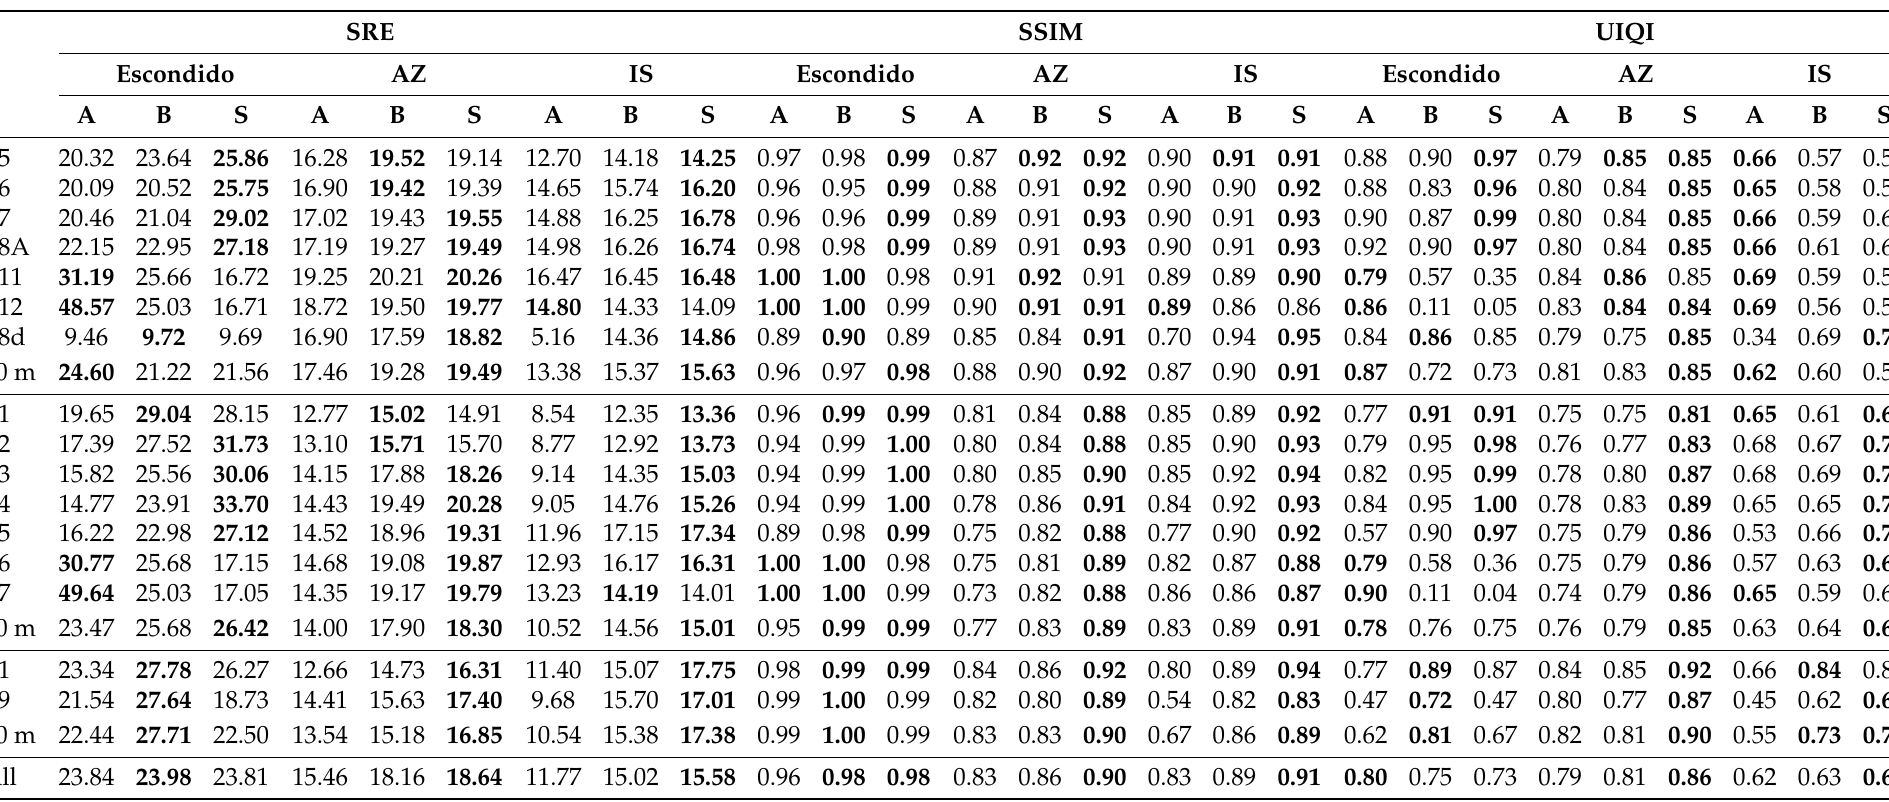
Table 2. The SRE, SSIM, and UIQI scores for the reduced scale images of IS, AZ, and the simulated image of Escondido. Higher values are better. The columns are labeled A for ATPRK, B for baseline, and S for SLSharp. The best results are shown in bold. SSIM